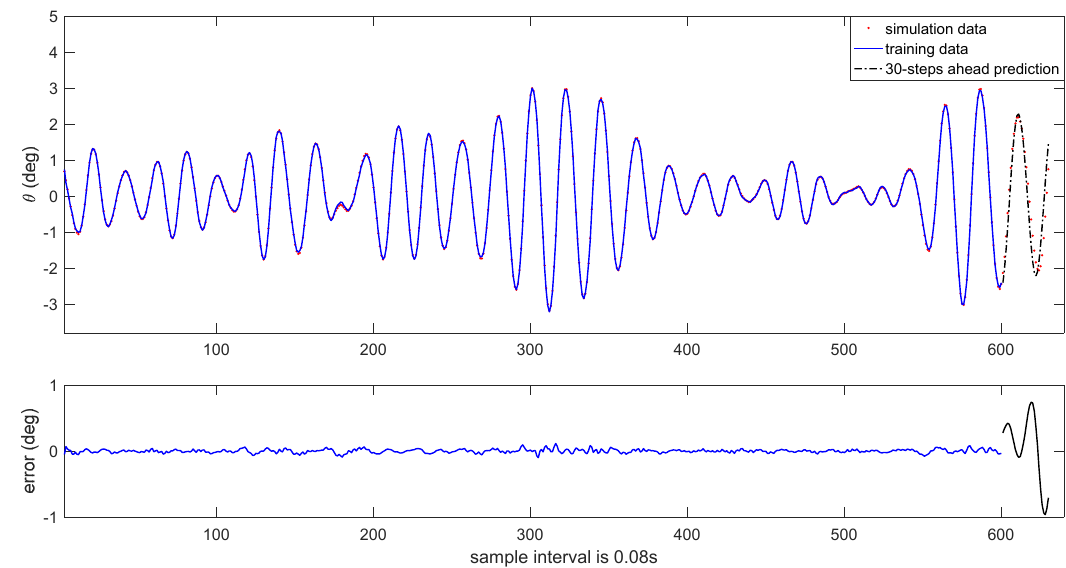
Figure 17. The 30-steps-ahead prediction of pitch motion in irregular waves for the FPSO model. As the sliding data window continues to move, it receives new data and the model can be adjusted online. For example, when the sliding data window receives the data at the sampling instant k = 763, the corresponding model is identified as follows: